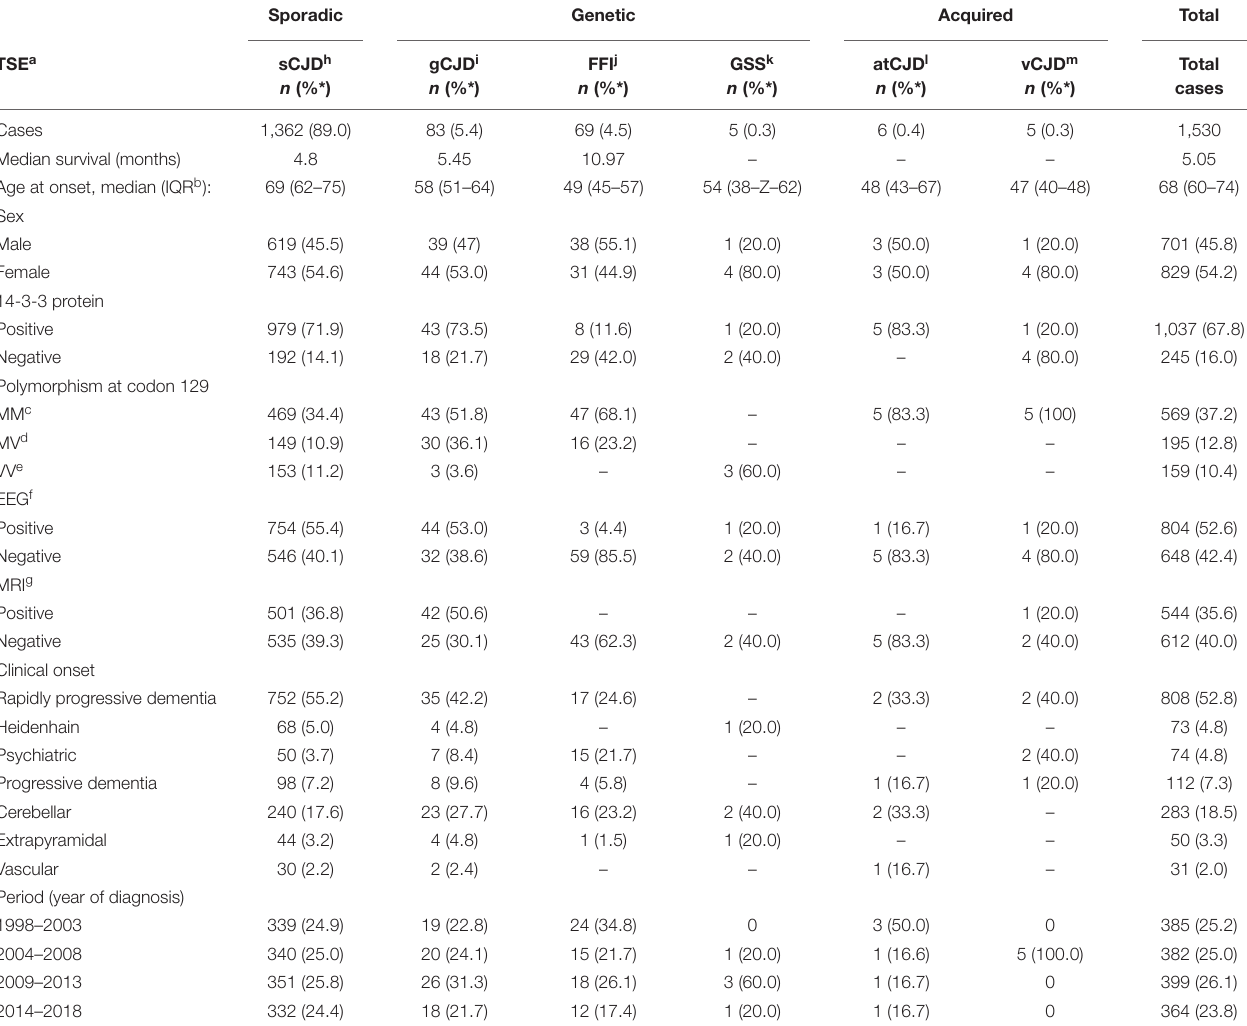
TABLE 1 | Characteristics of total definite and probable transmissible spongiform encephalopathy cases in Spain from 1998 to 2018 included in this study. Sporadic Genetic Acquired